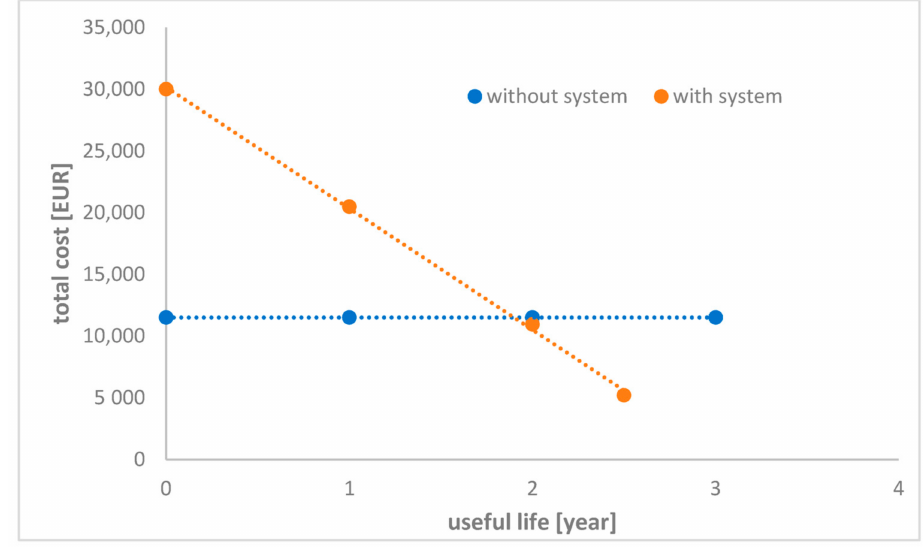
Figure 8. Comparison of costs with and without a backwash water recovery